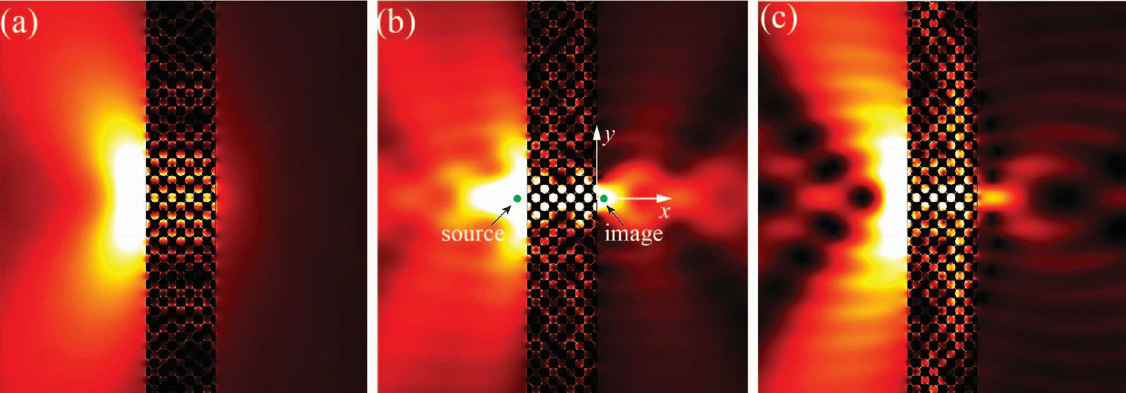
Figure 5. Normalized intensity field of a point source and its image across an 8-layer phononic slab at normalized frequency Ω = 0.200 ( a ), Ω = 0.230 ( b ) and Ω = 0.237 ( c ). The dark (light) color denotes low (high) intensity value.